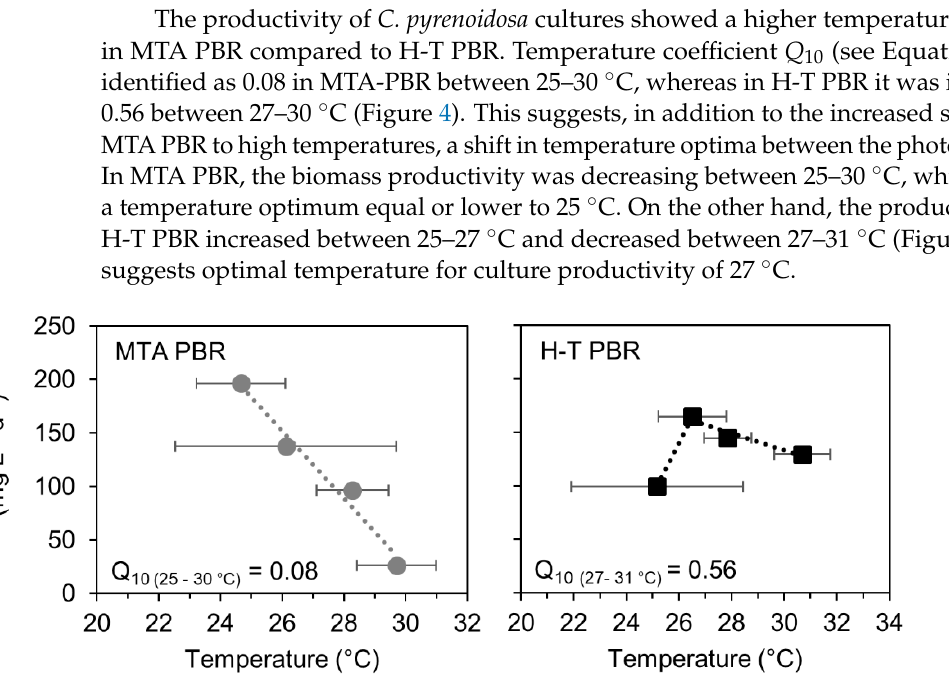
Figure 4. Temperature dependence of biomass productivity in MTA PBR (left panel) and H-T PBR (right panel) under nutrient sufficiency. Each point represents average daily temperature as measured during 8 days of C. pyrenoidosa culti- vation in June, July, September and October 2018, error bars represent standard deviations. Biomass productivity was determined from a single point measurement at 8th cultivation day, data of C. pyrenoidosa growth are summarized in Figure 2. Temperature coefficient Q 10 was calculated according to Equation (2).